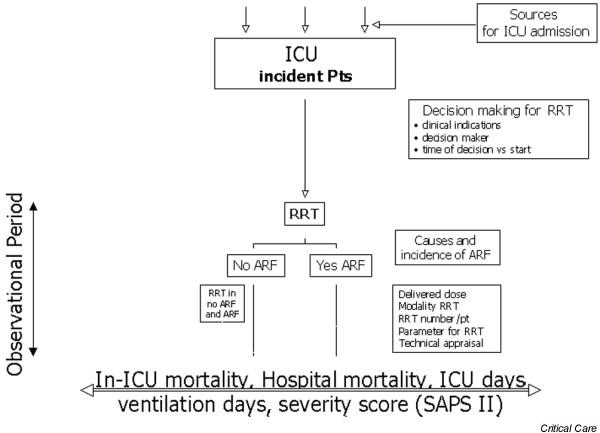
Flowchart of the DO-RE-MI observational study. All incident patients admitted to the intensive care unit (ICU) and requiring renal replacement therapy (RRT) will be followed up during RRT. At discharge, primary and secondary end-points will be recorded. All data will be entered in electronic case report form (CRF) and stored in a website [11]. The rectangles indicate the type of information that will be available from this study. ARF, acute renal failure; DO-RE-MI, DOse REsponse Multicentre International collaborative initiative; SAPS, Simplified Acute Physiology Score.